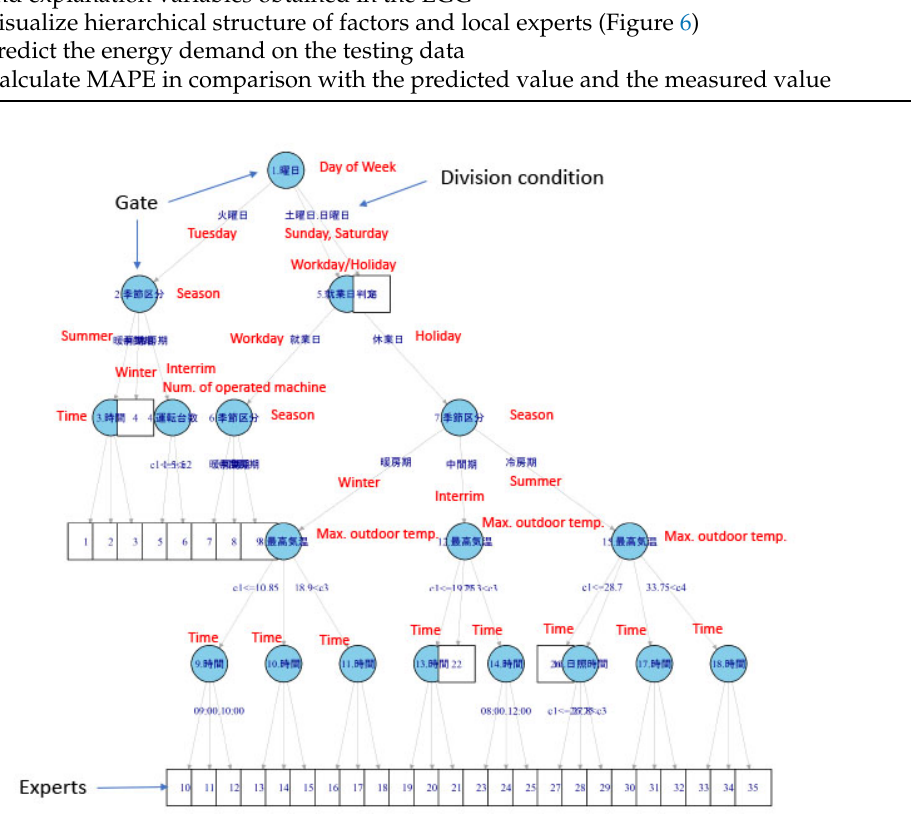
Figure 6. Example of visualization of gates and experts by the EP